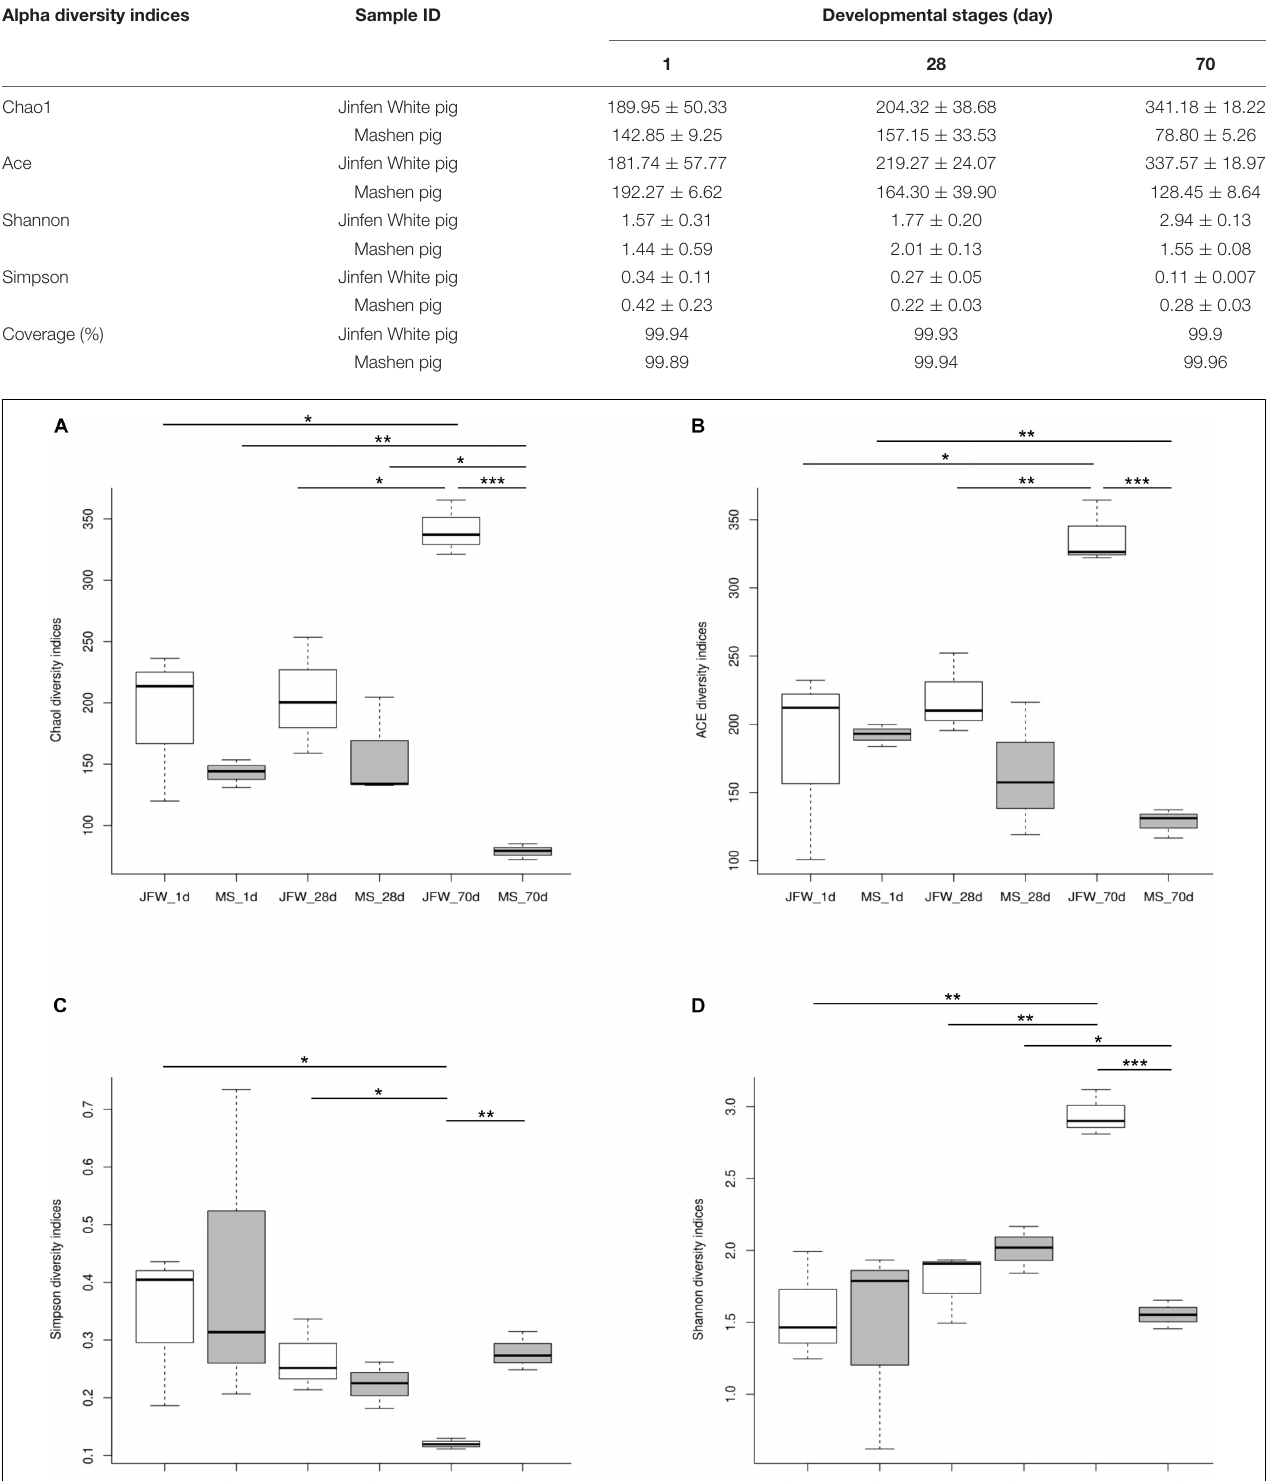
TABLE 1 | The alpha diversity indices of Jinfen White piglets and Mashen piglets.